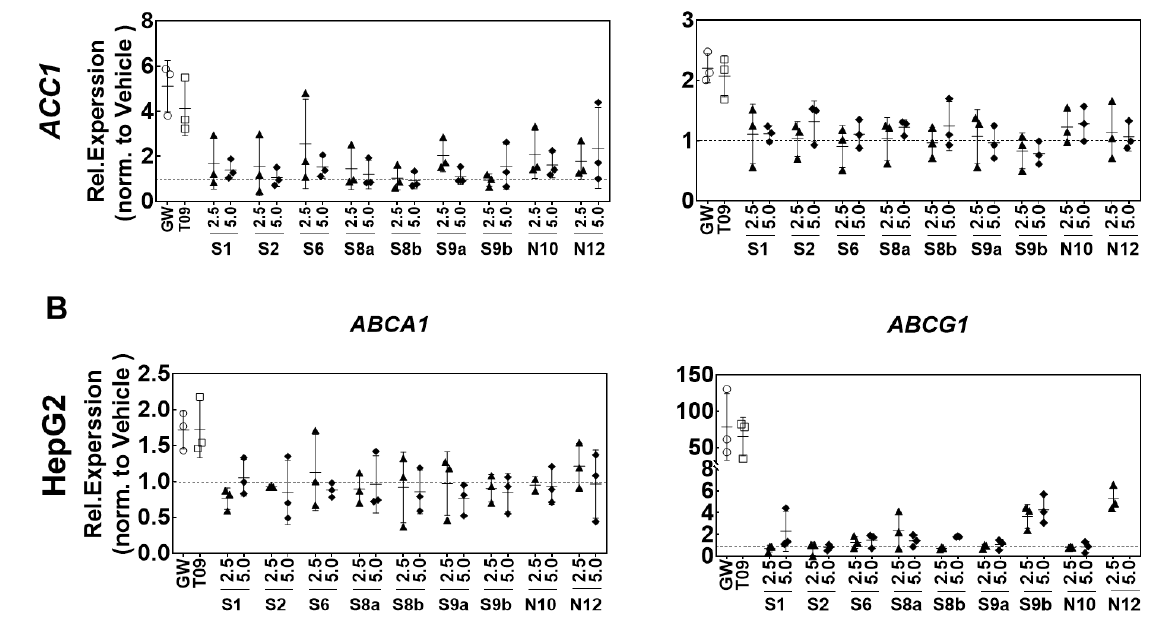
Figure 4. Effects of LXR-activating oxidized sterols on the gene ’ s expression of lipogenesis. ( A ) SREBF1, SCD1, FASN and ACACA expression in CCG-STTG1 or HepG2 cells. ( B ) ABCA1 and ABCG1 expression in HepG2 cells. Cells were incubated with EtOH (0.1%, v/v ), DMSO (0.1%, v/v ), 1 μM T0901317 (T09), 5 μM GW3965 (GW), 2.5 or 5.0 μM of oxysterols for 24 h and gene expression was assessed by qPCR. Gene expression was normalized to the most stable housekeeping genes (SDHA, B2M, ACTB, and HPRT1) and expressed as Relative. Expression compared to the vehicle control (EtOH or DMSO) given as means of three experiments ± SD ( n = 3).